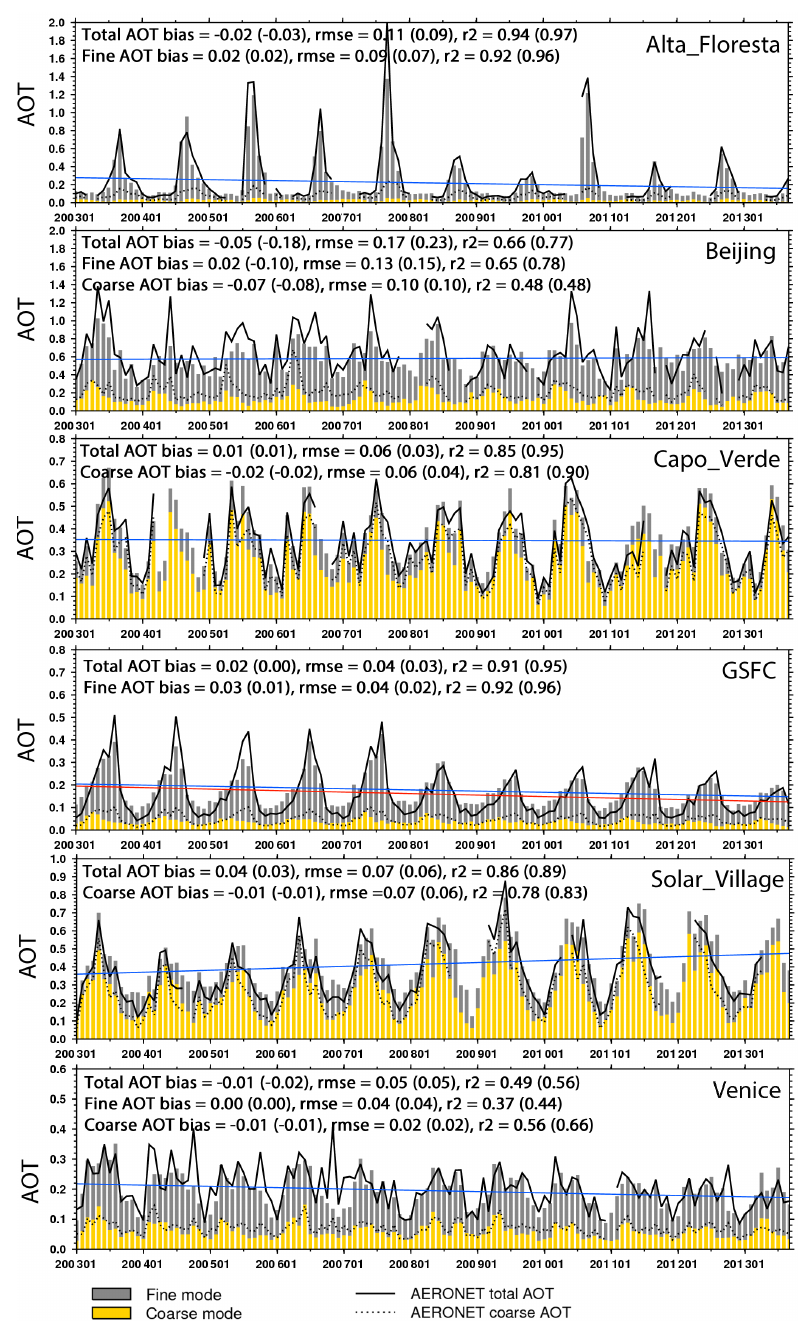
Figure 14. Monthly mean 550nm reanalysis and AERONET L2 mode AOTs at six AERONET sites, Alta Floresta in the Amazon, Beijing in East Asia, Capo Verde off the west coast of northern Africa, GSFC in East CONUS, Solar Village in Arabian Peninsula, and Venice in Italy. The solid blue line is a linear regression of the reanalysis total AOT. The red solid line is a linear regression of the AERONET total AOT, only available when there is continuous data through the time. Monthly mean AERONET AOT is obtained only when the total number of 6-hourly AERONET data exceeds 10 to ensure temporal representativeness. Annotations for each time series show bias, RMSE and r 2 of monthly averages for unpaired comparisons; paired comparisons, using reanalysis values sampled to match available AERONET data, are shown in